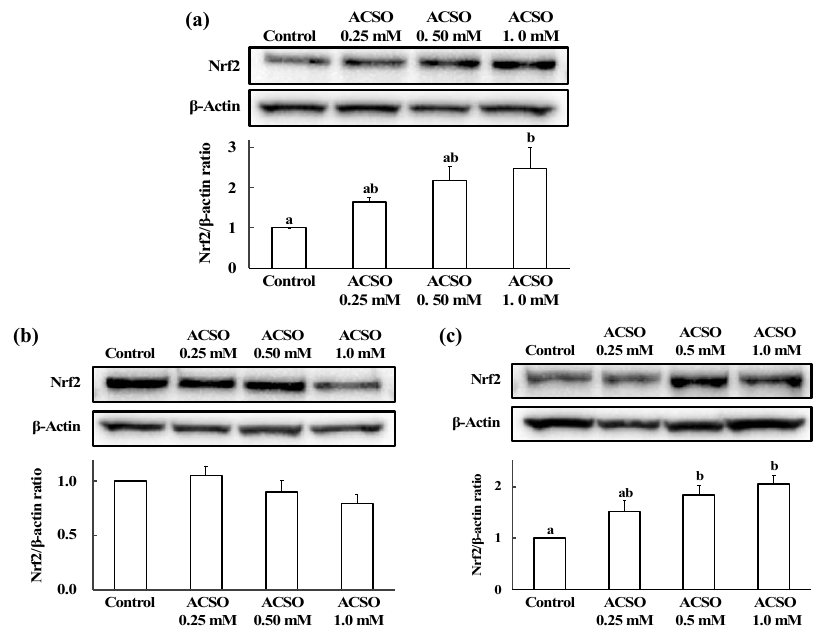
Figure 6. Effect of ACSO on Nrf2 nuclear translocation in HepG2 cells. The expression levels of Nrf2 were analyzed by Western blot analysis in whole cell ( a ), cytoplasm ( b ), and nuclei ( c ) preparations of HepG2 cells. Expression was quantified as the ratio of Nrf2 expression to β-actin expression. Each value represents the mean of three experiments ± S.E. The different letters indicate a significant difference between the groups ( p < 0.05).